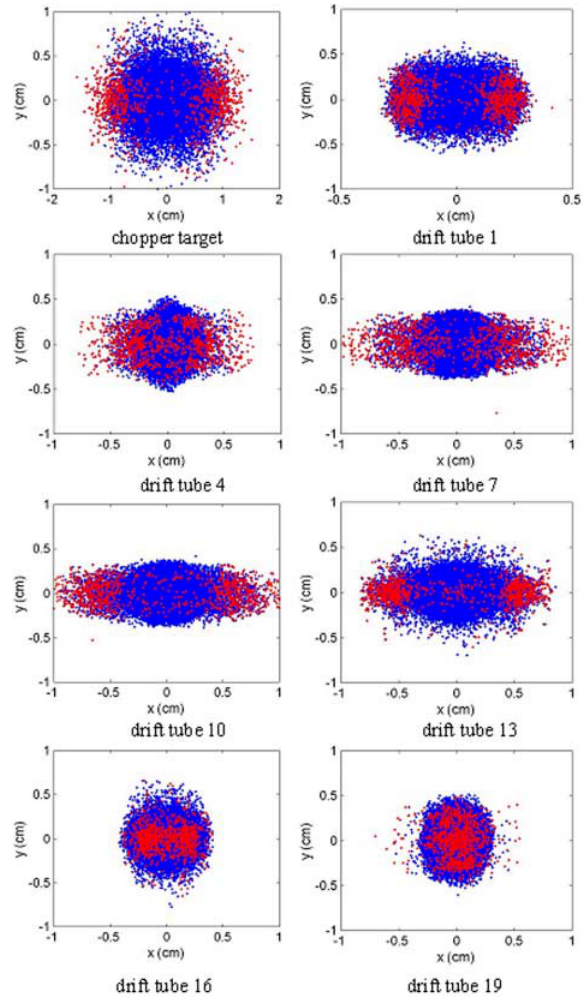
FIG. 16. (Color) Real space projections of the beam distribution at the MEBT chopper target and at the first seven of the proposed DT collimators. Halo particles “at risk” are plotted in